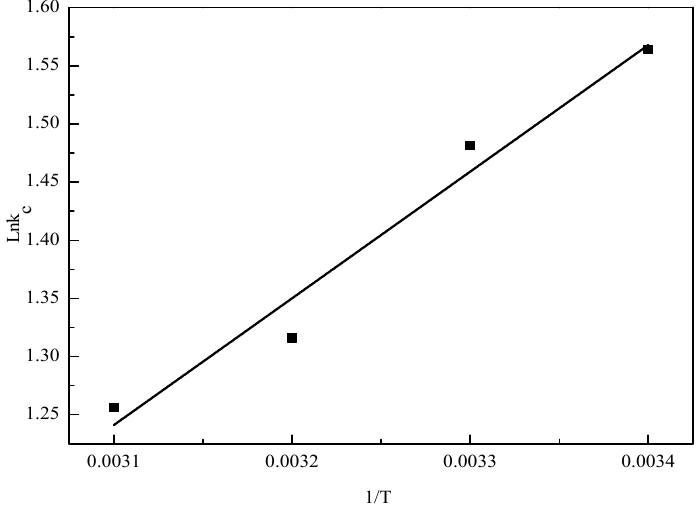
Figure 8. Van’s Hoff plot for the Cd(II) removal by the nZVI/rGO composites. Table 8. Thermodynamic parameters for Cd(II) removal by the nZVI/rGO composites.